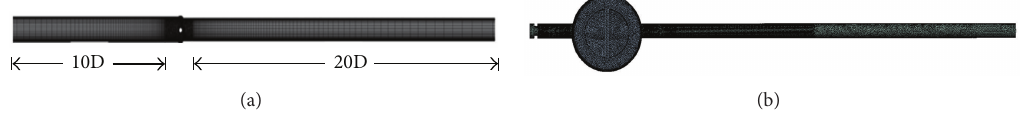
Figure 2: Models and grid systems generated for the structural and flow analyses: (a) flow and (b) structure.